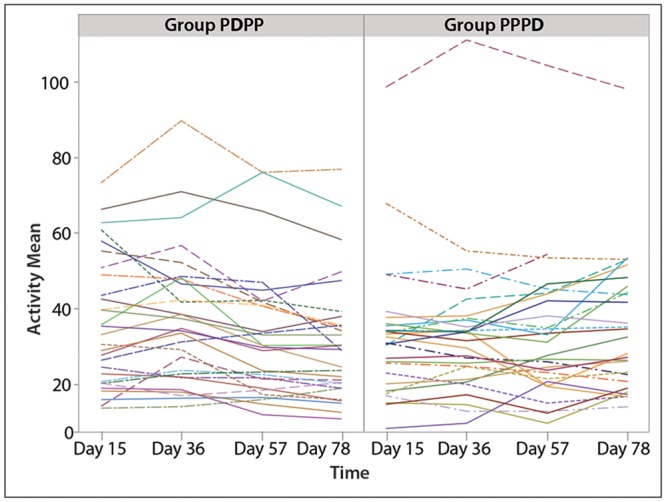
Plots of mean activity counts per day for individual cats in the PDPP (meloxicam first) and PPPD (placebo first) groups.These plots highlight the marked inter-cat variability in activity seen throughout the study.